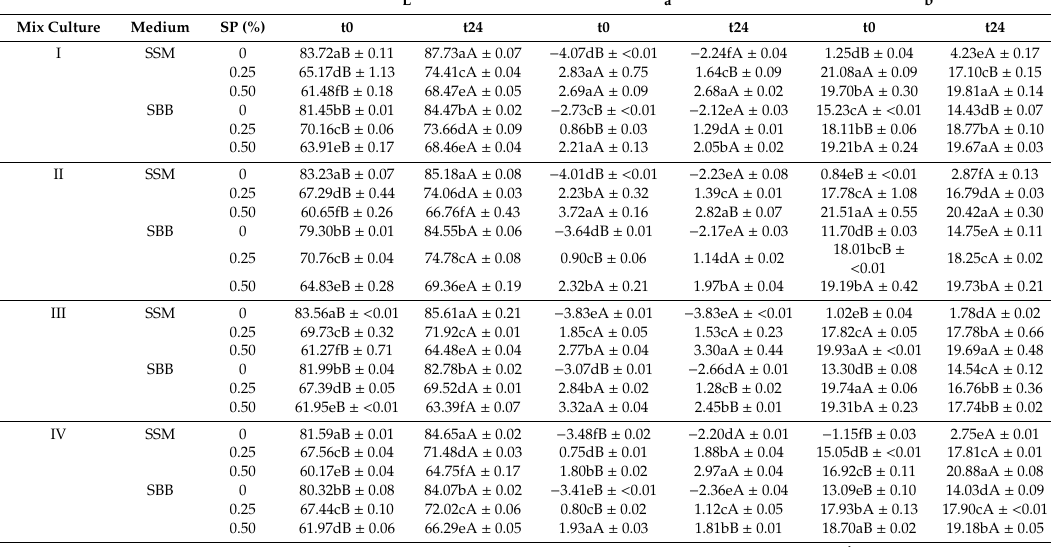
Table 4. Results of colorimetric coordinates L*, a*, b* of each mix culture inoculated in skimmed milk (SSM) and soymilk